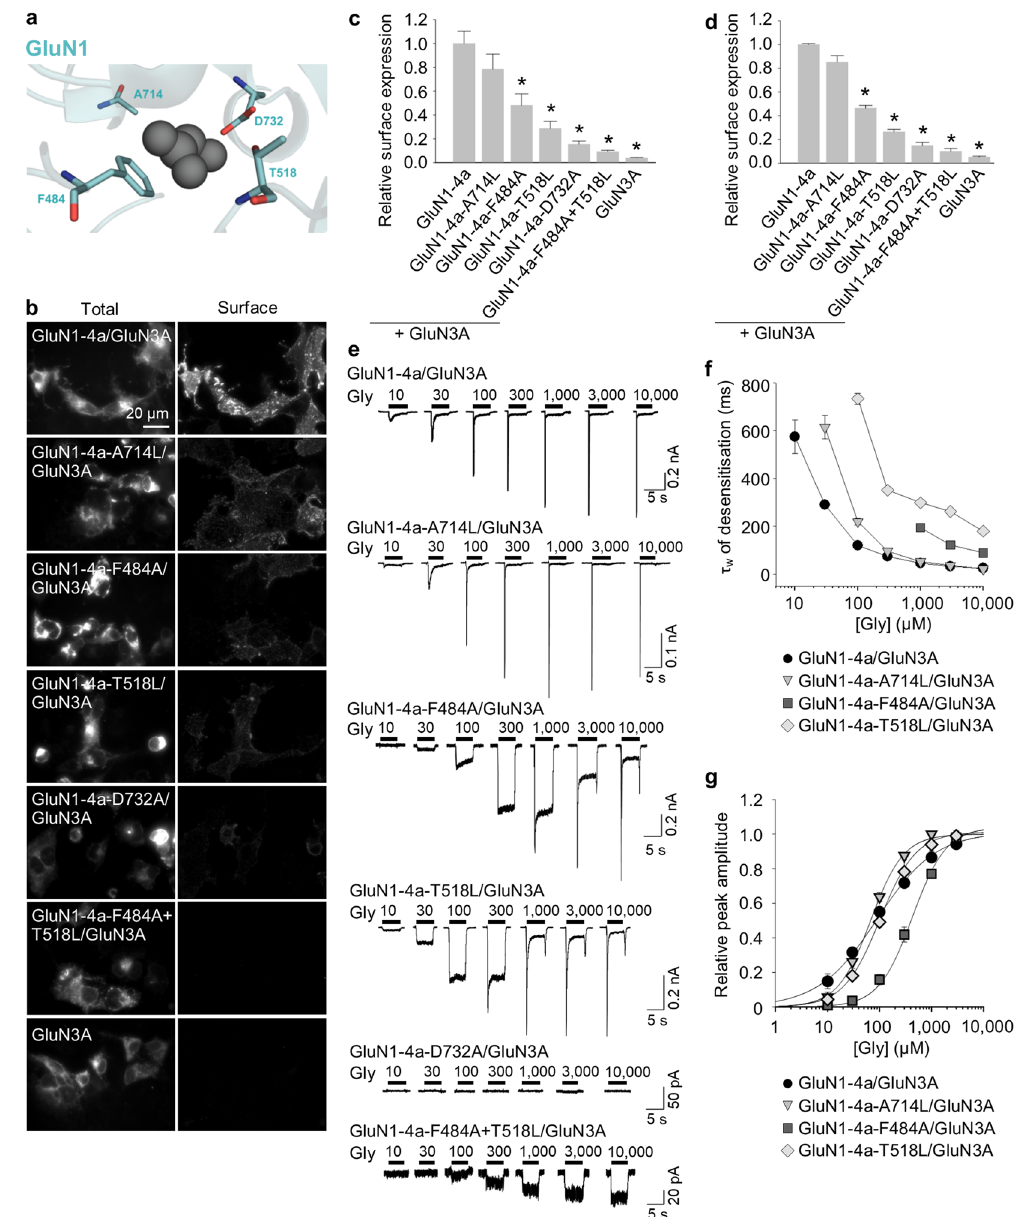
Figure 2. Mutations in the glycine-binding site in the GluN1 subunit alter the surface expression and desensitisation kinetics of GluN1/GluN3A receptors. (a) Schematic representation of the glycine-binding site in the GluN1 subunit (PDB code: 1PB7); the amino acid residues studied here, and a glycine molecule, are shown. ( b ) Representative images of COS-7 cells transfected with the indicated wild-type or mutant GluN1-4a subunits together with GFP-GluN3A (GluN3A) subunit and labelled 24 h after transfection. (c) Summary of the relative surface expression of the indicated GluN subunits measured using fluorescence microscopy (n ≥ 24 cells per group); * p < 0.05 vs. GluN1-4a/GluN3A (ANOVA). (d) Quantification of relative surface expression of the indicated GluN1-4a/GFP-GluN3A (GluN1-4a/GluN3A) receptors using quantitative colorimetric assay is shown (n = 6); * p < 0.05 relative to GluN1-4a/GluN3A (ANOVA). ( e ) Representative whole-cell patch- clamp recordings from HEK293 cells transfected with the indicated wild-type or mutant GluN1-4a/GluN3A receptors. Currents were elicited by applying glycine at the indicated concentrations. ( f ) Summary of the τ w of desensitisation for the indicated GluN1-4a/GluN3A receptors (n ≥ 5 cells per group). ( g ) Peak concentration- response curves for the indicated GluN1-4a/GluN3A receptors. Each data point represents the mean relative current from ≥ 5 independent cells. The EC 50 values and Hill coefficients are listed in Table